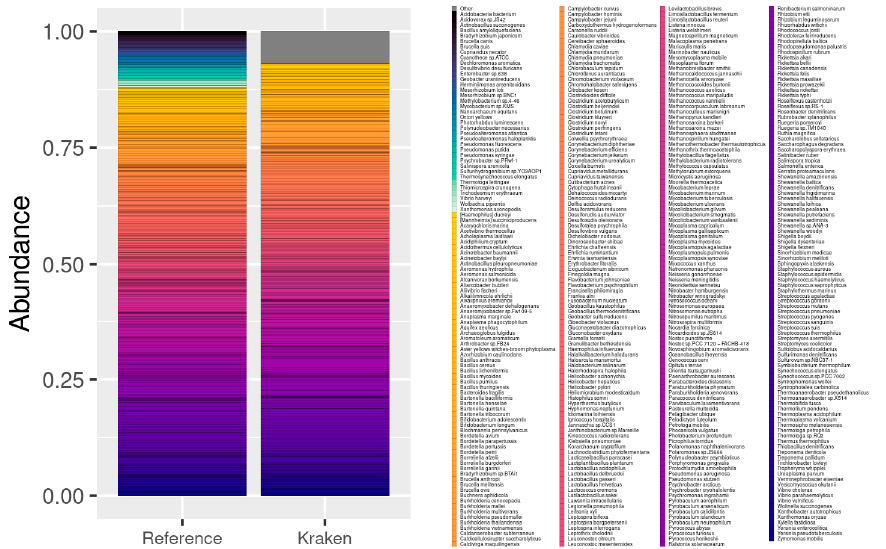
Figure 6. Stacked barplot depicting relative abundance between Reference abundance and Kraken/Bracken pipeline in the 400 species data from Mendo and collaborators . Each vertical bar depicts the relative abundance according to Reference data and Kraken/Bracken pipeline analysis (Kraken bar). Counts associated with false positive OTUs are coloured in grey. A different colour palette was used to represent the reference species not detected by the pipeline. The list of OTUs in the legend is included in Supplementary Table S4.